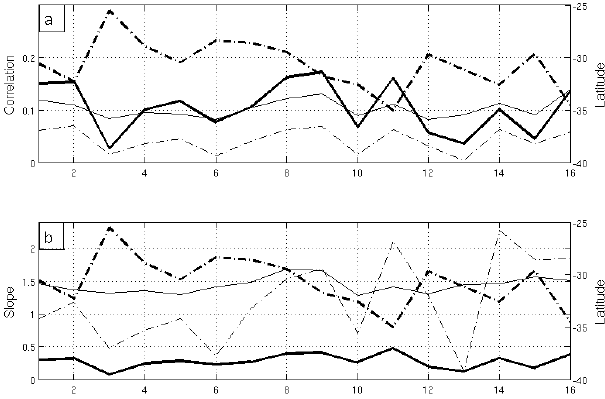
Figure 9. Correlations (a) and slopes (b) between T 0 × V 0 as thick continuous lines, ( ∇ . u ) 0 × (∂T/∂d) 0 as thin continuous lines and − ( ∇ × u ) 0 × (∂T/∂c) 0 as thin dash-dotted lines and the mean Latitude (thick dash-dotted line) for the 16 Agulhas rings identified in the present study. A remarkable anti-correlation of the correlations and slopes with the Latitude is observed